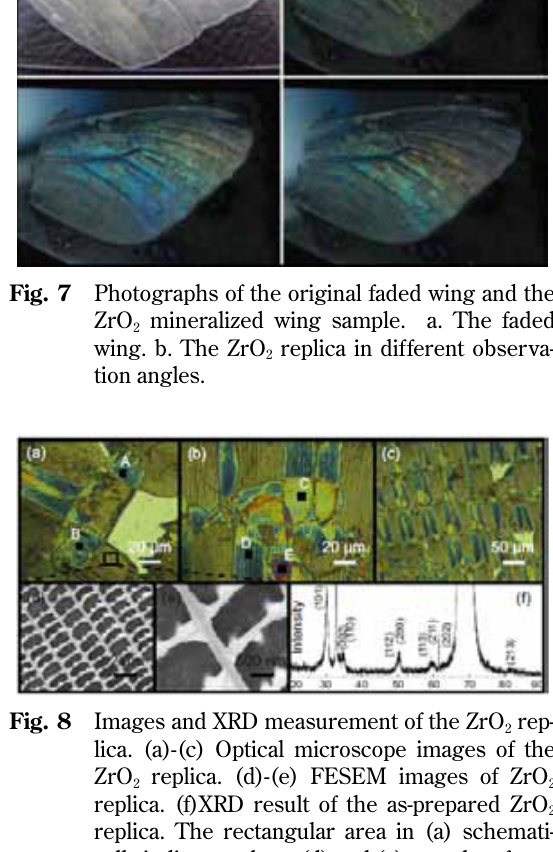
Fig. 8 Images and XRD measurement of the ZrO lica. (a)-(c) Optical microscope images of the ZrO replica. (d)-(e) FESEM images of ZrO 2 replica. (f)XRD result of the as-prepared ZrO replica. The rectangular area in (a) schemati- cally indicates where (d) and (e) are taken